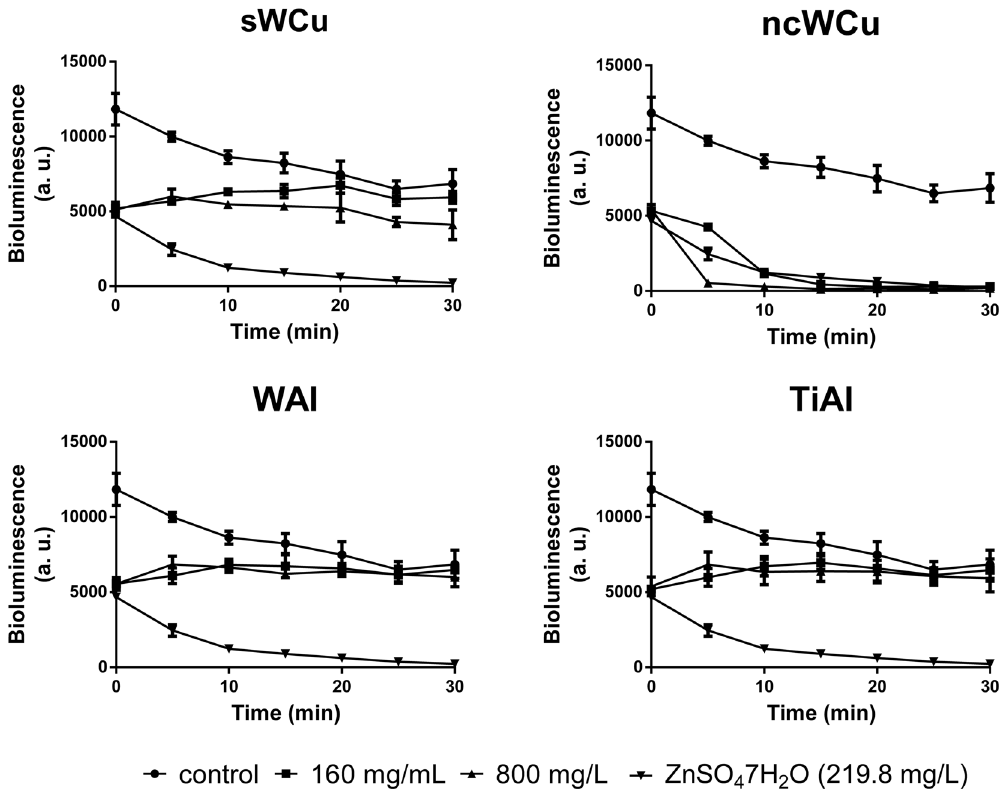
Figure 6. Impact of the different metal powder leachates in the bioluminescence of V. fischeri during a 30 min-